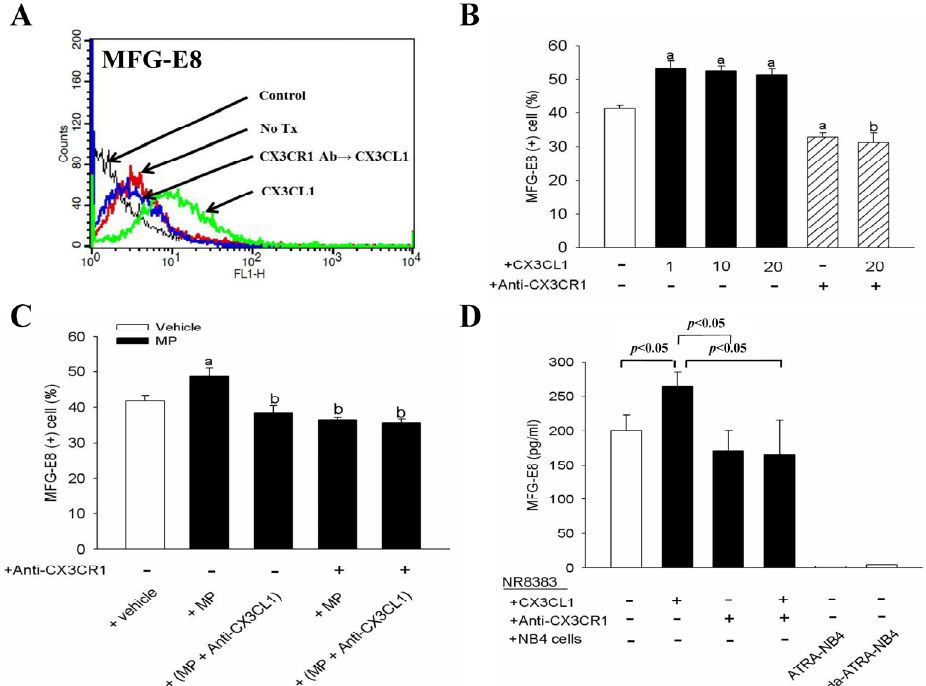
Figure 4. CX3CL1 and apoptotic cell-derived MP enhance NR8383 cells in surface expression and release of MFG-E8. Surface expression of MFG-E8 on NR8383 cells as determined by flow cytometric analysis. ( A , B ) NR8383 cells were treated with exogenous CX3CL1 ( B : black bar) or pre-treated with anti-CX3CR1 antibody before CX3CL1 treatment ( A : CX3CR1 Ab → CX3CL1; B : striped bar). a; p < 0.05 vs. blank bar; b; p < 0.05 vs. first right black bar. ( A ) This is a representative picture from five independent experiments and ( B ) presents the bar graph data of those five experiments. ( C ) NR8383 cells were incubated with either vehicle alone (blank bar) or Ida-ATRA-NB4 cell-derived apo-MP (black bar); in addition, a subset of the NR8383 cells was pre-treated with anti-CX3CR1 antibody and some of the MP were pre-treated with anti-CX3CL1 antibody (MP + Anti-CX3CL1) before both were incubated together for flow cytometric analysis. a: p < 0.05 vs. blank bar; b: p < 0.05 vs. left first black bar. ( D ) The levels of MFG-E8 were determined by ELISA in (1) the CM of NR8383 cell culture alone (blank bar); (2) the CM of NR8383 cells treated either CX3CL1, anti-CX3CR1 antibody, or both (black bars); and (3) the CM of NR8383 cells co-cultured with either ATRA-NB4 cells or Ida-ATRA-NB4 cells. ( C , D ) The results are the means ± SD from five independent experiments.